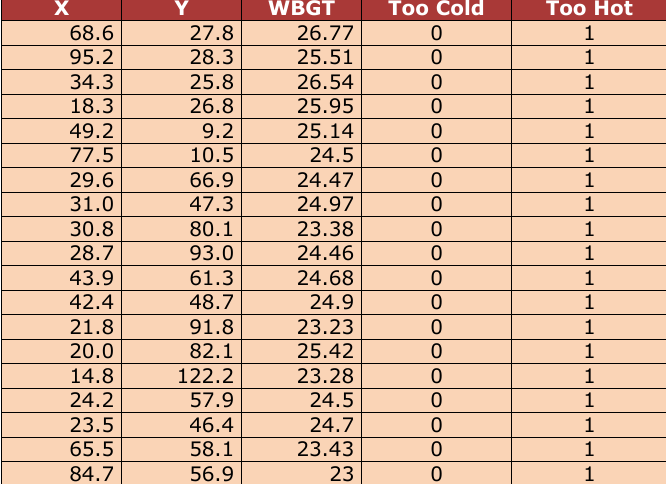
Table 8. WBGT and